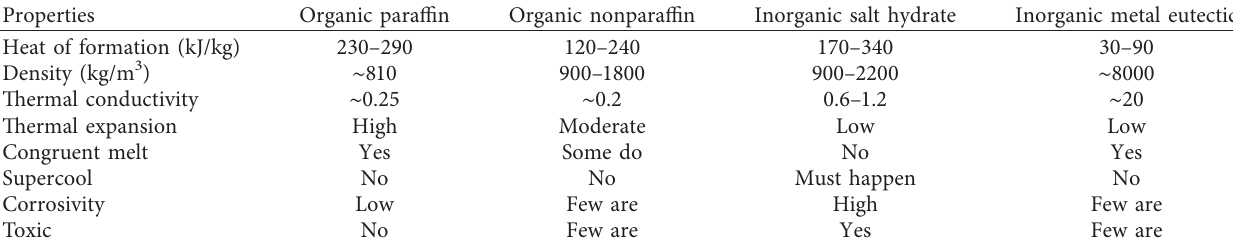
Table 1: Properties of various types of